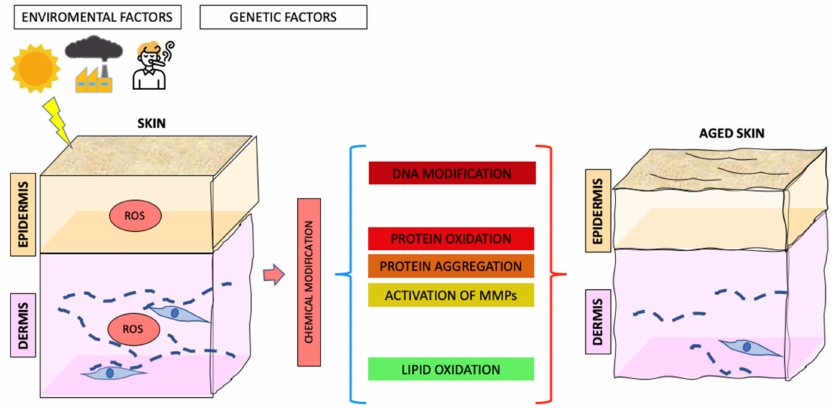
Figure 1. Main factors involved in skin aging and consequences leading to aged skin.